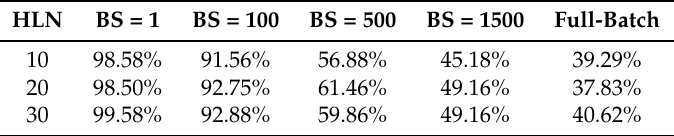
Table 3. RFI Classification results based on MLP at different HLN and